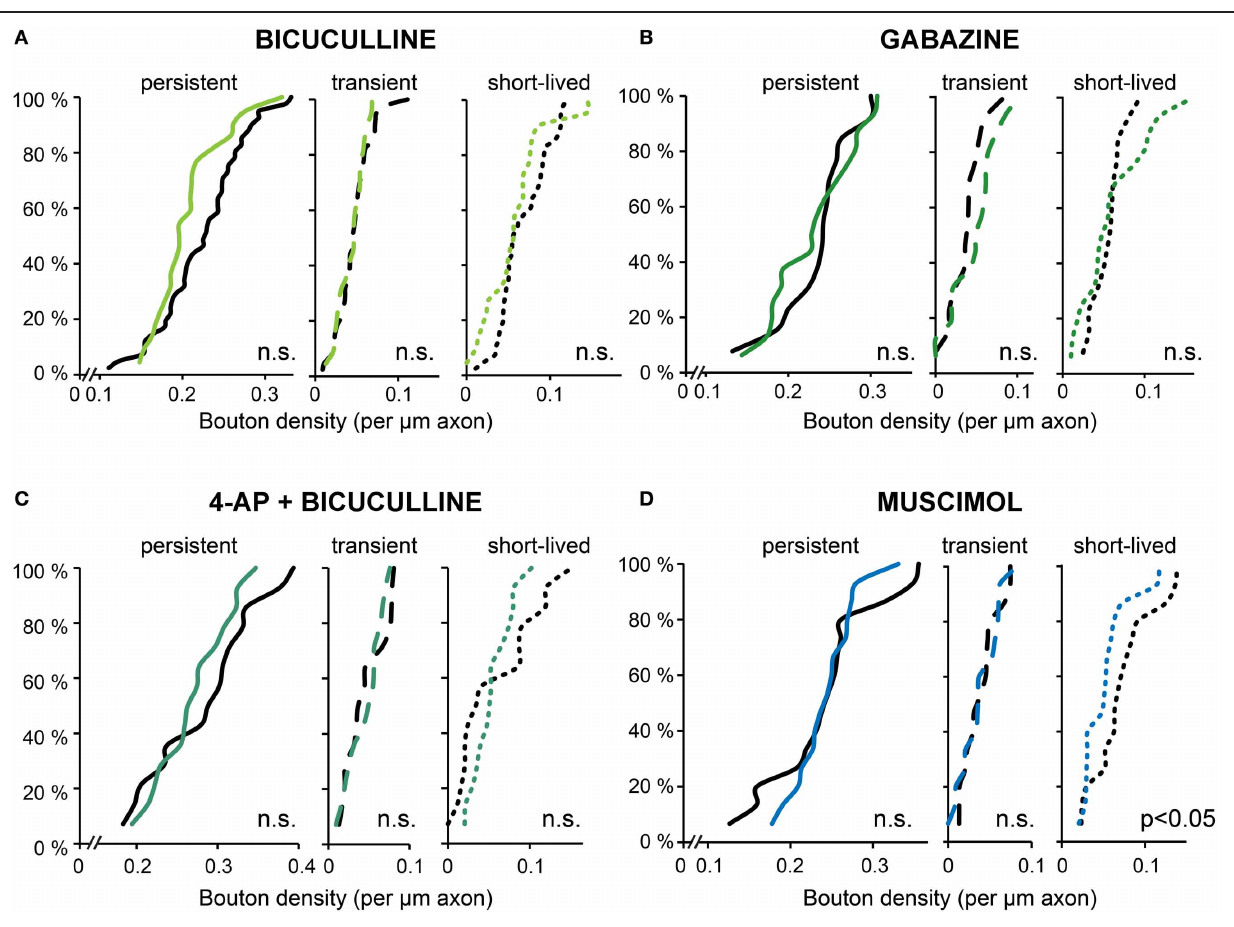
axons: bicuculline: 22 treated and 41 control axons; gabazine: 16 treated and 13control axons; AP + bicuculline: 14 treated and 14 control axons; muscimol: 15 treated and 15control axons (Student’s t -test).